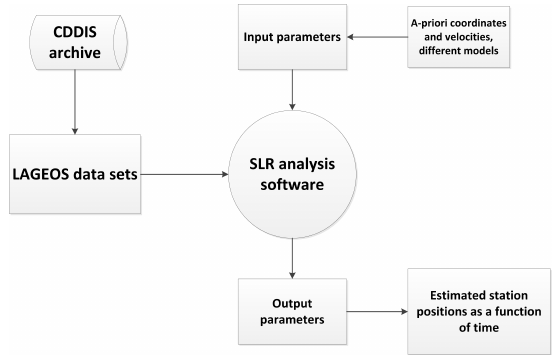
Fig. 5. Schematic representation of SDAS software (modified from Botai,